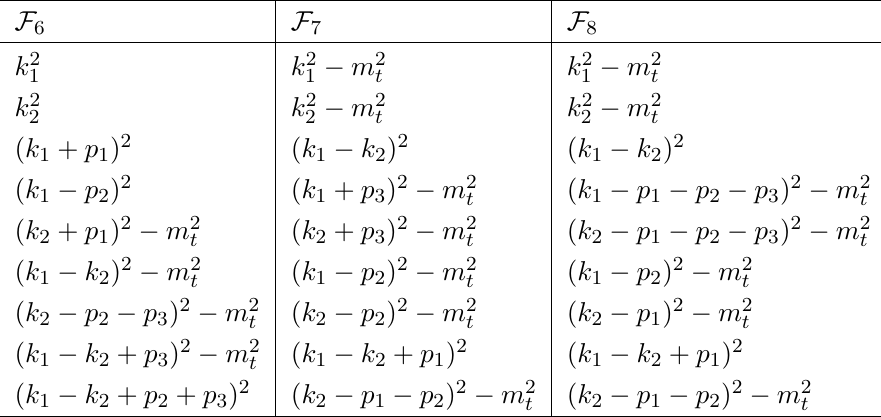
Table 2 . Non-planar integral families used for the